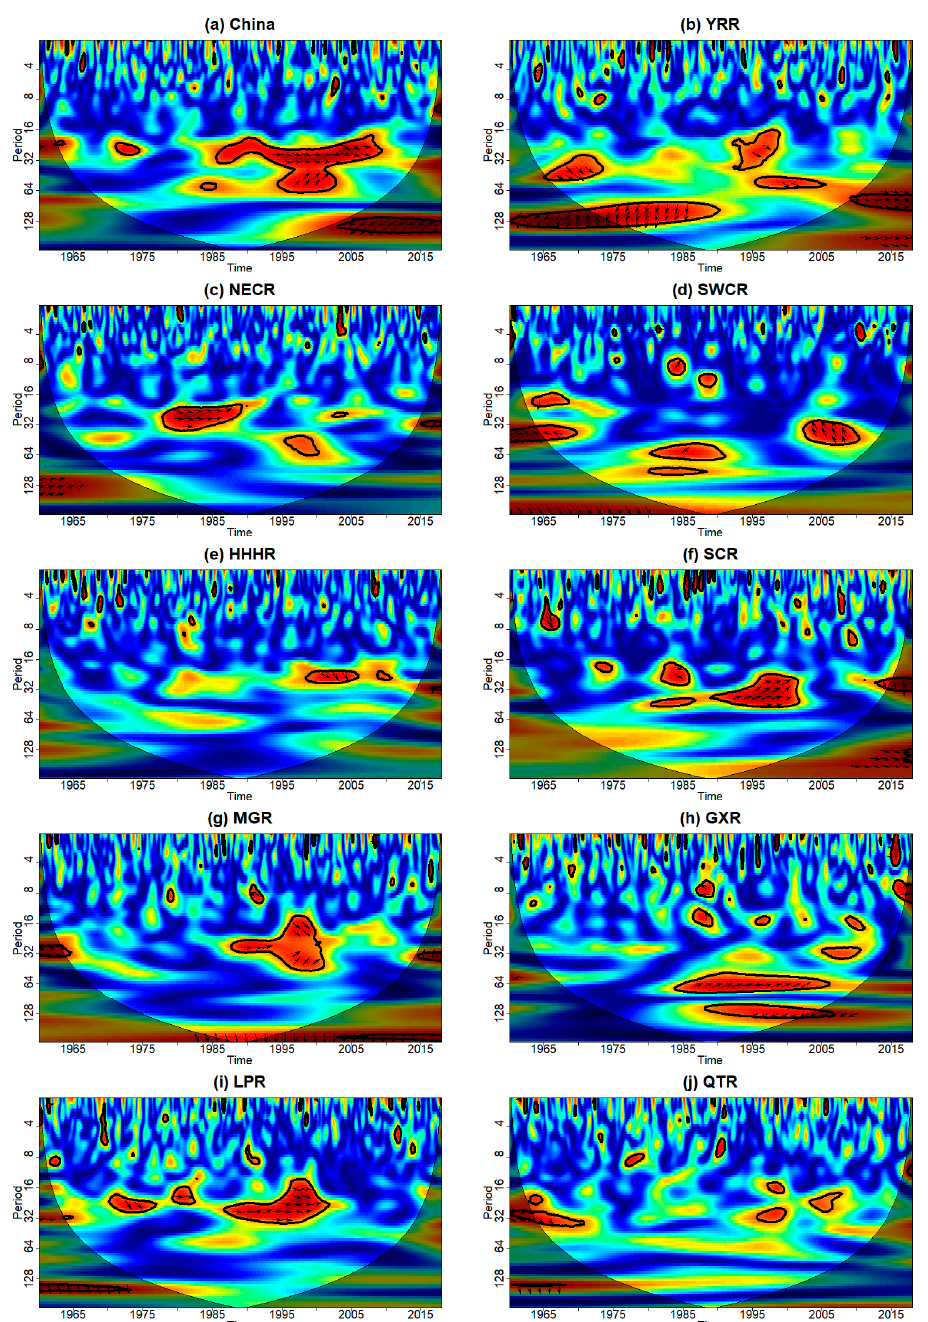
Figure 6. Cross-wavelet analysis for investigating the factors affecting SPEI variability: ( a ) SPEI and WPTW in Chinese mainland, ( b ) SPEI and WPSHI in YRR, ( c ) SPEI and WPTW in NECR, ( d ) SPEI and EPSH in SWCR, ( e ) SPEI and WPTW in HHHR, ( f ) SPEI and WPSHI in SCR, ( g ) SPEI and CPTW in MGR, ( h ) SPEI and AAO in GXR, ( i ) SPEI and CPTW inLPR, and ( j ) SPEI and CPTW in QTR. The thick black contour designates the 95% confidence level against red noise, and the cone of influence (COI) where edge effects might distort the picture is shown as a lighter shade. The cross-wavelet transform shows the relations between SPEI and WPTW / CPTW / WPSHI / EPSH / AAO. The relative phase relationship is shown as arrows (with in-phase pointing right, anti-phase pointing